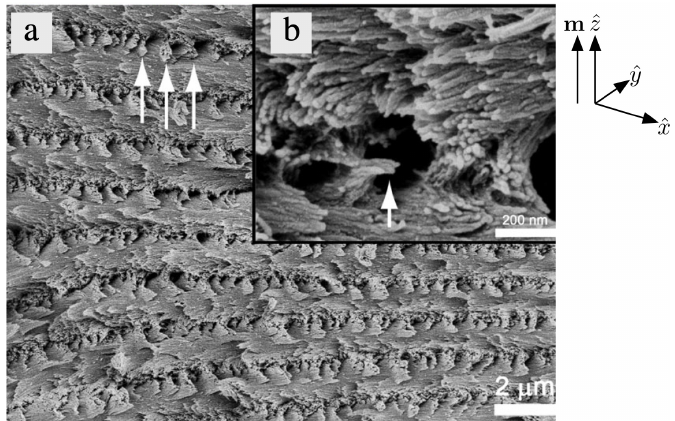
Figure 4. ( a ) Scanning Electron Microscopy image with exceptional detail of the surface obtained by fracturing a film created by drying a cholesteric CNC suspension, the axis m of the helical director modulation being nearly in the film plane and vertical in the image. White arrows highlight regions where CNC rods protrude from the fracture surface. The inset ( b ) shows individual CNCs near such a region, where n is perpendicular to the fracture plane. Next to the protruding CNCs are holes, left by the removal of the corresponding rods that ended up stuck in the opposite fracture section. Note that rods are packed an order of magnitude closer in this solid film than in an equilibrium cholesteric liquid crystal phase, and their degree of order is probably greater as well. Reprinted by permission from Springer Nature Cellulose [49], Copyright